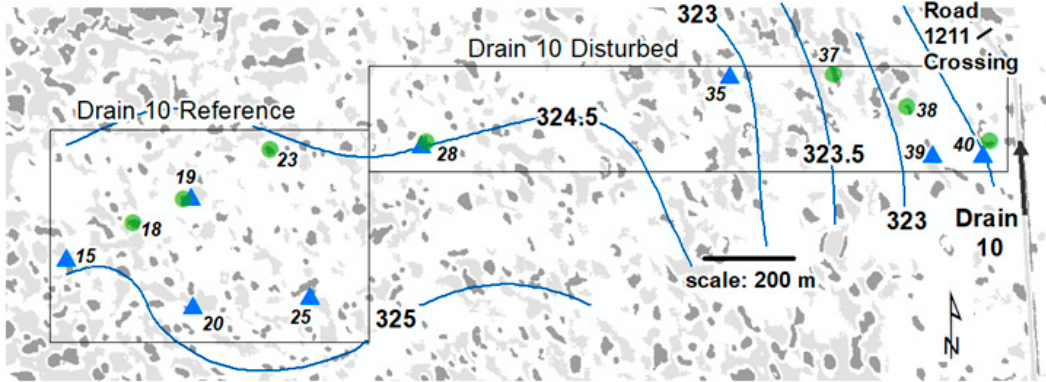
Figure 3. Map indicating dune crests (dark gray), swale bottoms (light gray), hydrological profiles (triangles), profiles used in characterizing vegetation (circles), and maximum water-table elevation in m (contour lines) (Table S1). Profile locations were selected within the rectangular boxes that outline the reference and disturbed areas.